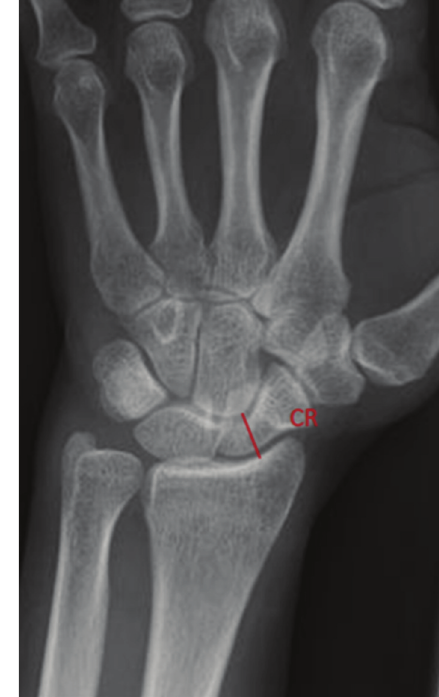
CR Index (CR) is the shortest distance between the distal Fig. 3: edge of radius and proximal end of